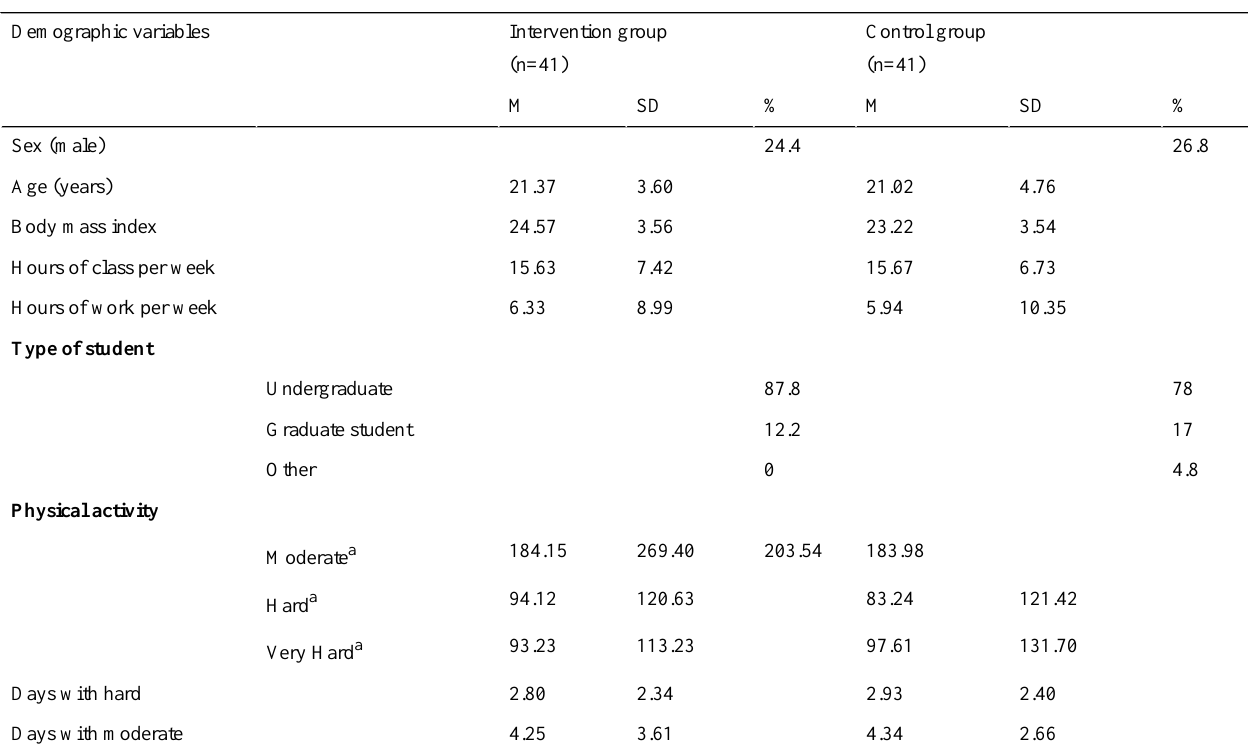
Table 1. Demographic variables of both groups at